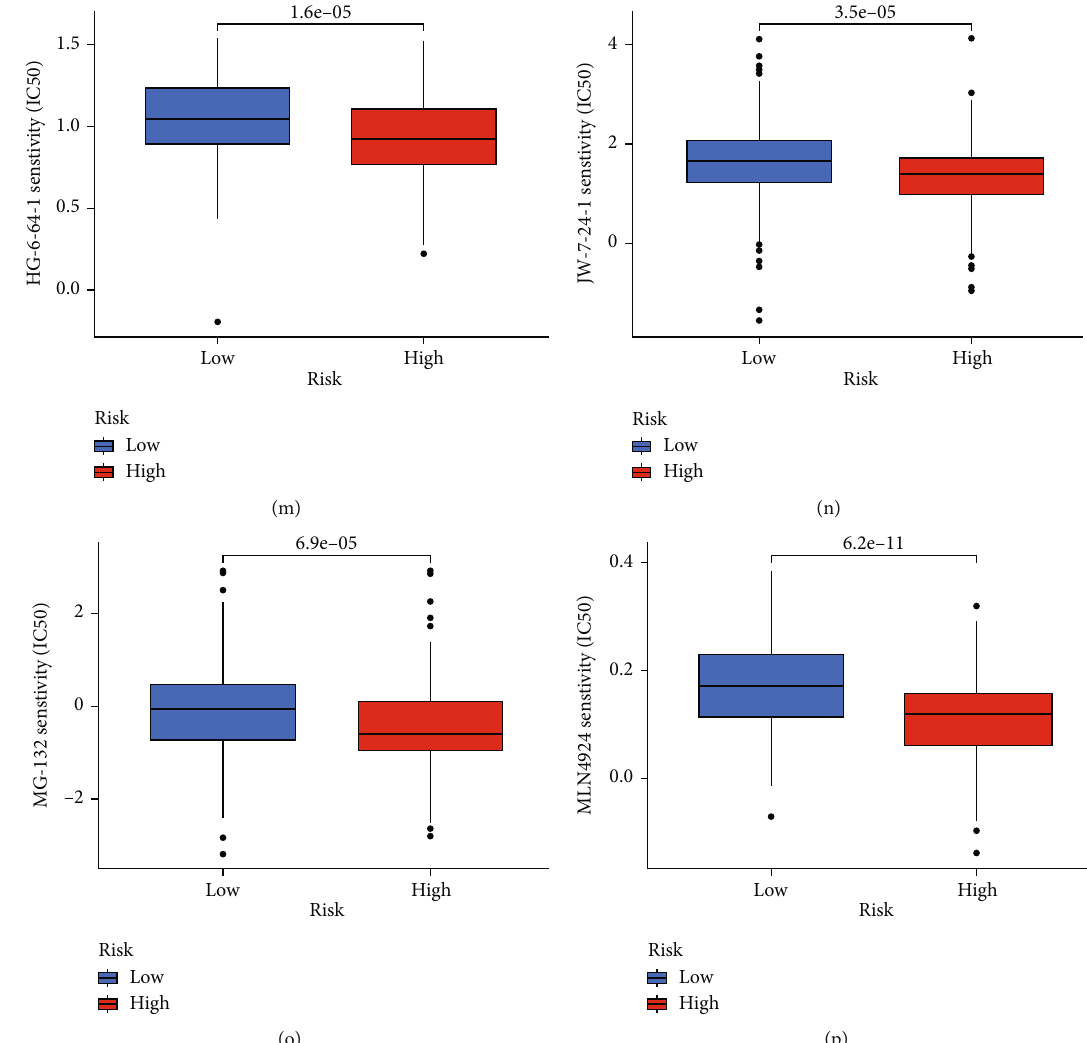
Figure 10: Potential drug screening. (a) AR-42 drug treatment e ff ect. (b) Axitinib drug treatment e ff ect. (c) Belinostat drug treatment e ff ect. (d) BEZ235 drug treatment e ff ect. (e) BMS345541 drug treatment e ff ect. (f) Bortezomib drug treatment e ff ect. (g) CAY10603 drug treatment e ff ect. (h) CP466722 drug treatment e ff ect. (i) CUDC-101 drug treatment e ff ect. (j) Cytarabine drug treatment e ff ect. (k) Elesclomol drug treatment e ff ect. (l) GSK429286A drug treatment e ff ect. (m) HG-6-64-1 drug treatment e ff ect. (n) JW-7-24-1 drug treatment e ff ect. (o) MG-132 drug treatment e ff ect. (p) MLN4924 drug treatment e ff